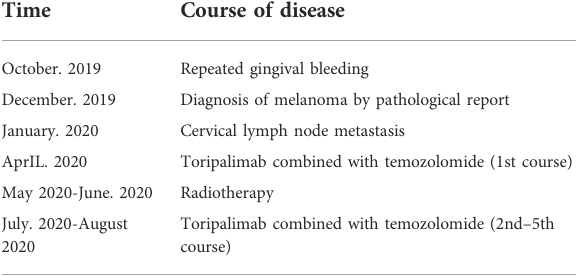
TABLE 3 Parameters of the